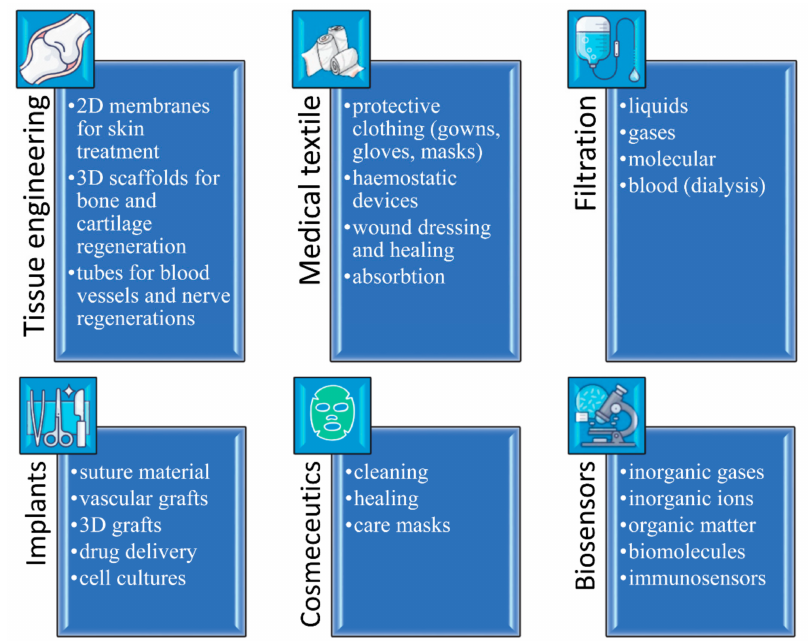
Figure 2. Biomedical applications of polymeric electrospun